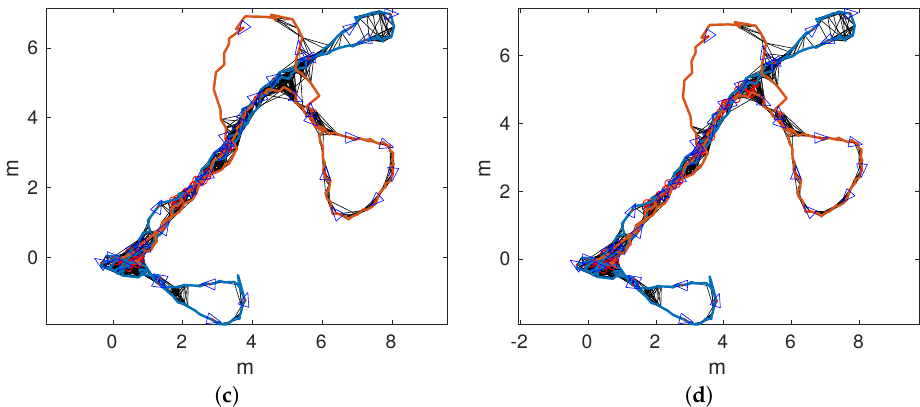
Figure 13. Obtained trajectories for V 1 and V 2: ( a ) MSLAM1, ( b ) MSLAM10, ( c ) MSLAM20, and ( d ) MSLAM30. In SLAM, thick lines are the trajectories, thin lines are the detected loops, and the triangles show the estimated AUV orientation.